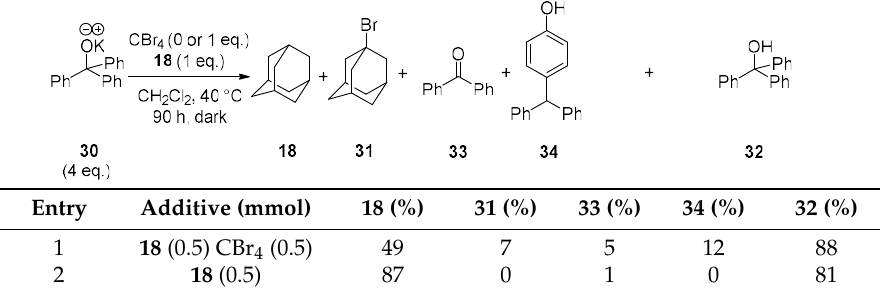
Table 2. The reaction of potassium triphenylmethanolate 30 in dichloromethane at 40 °C a